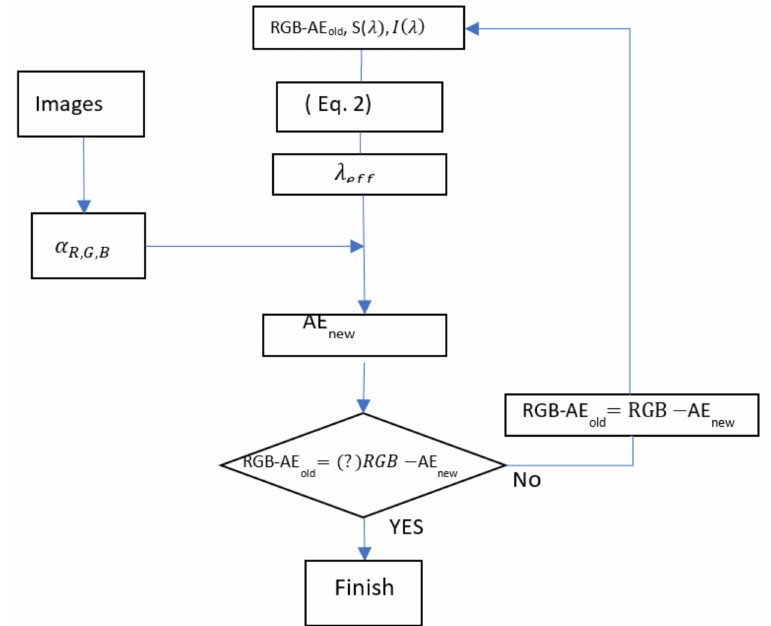
Figure 3. Flow chart for iterative RGB-AE